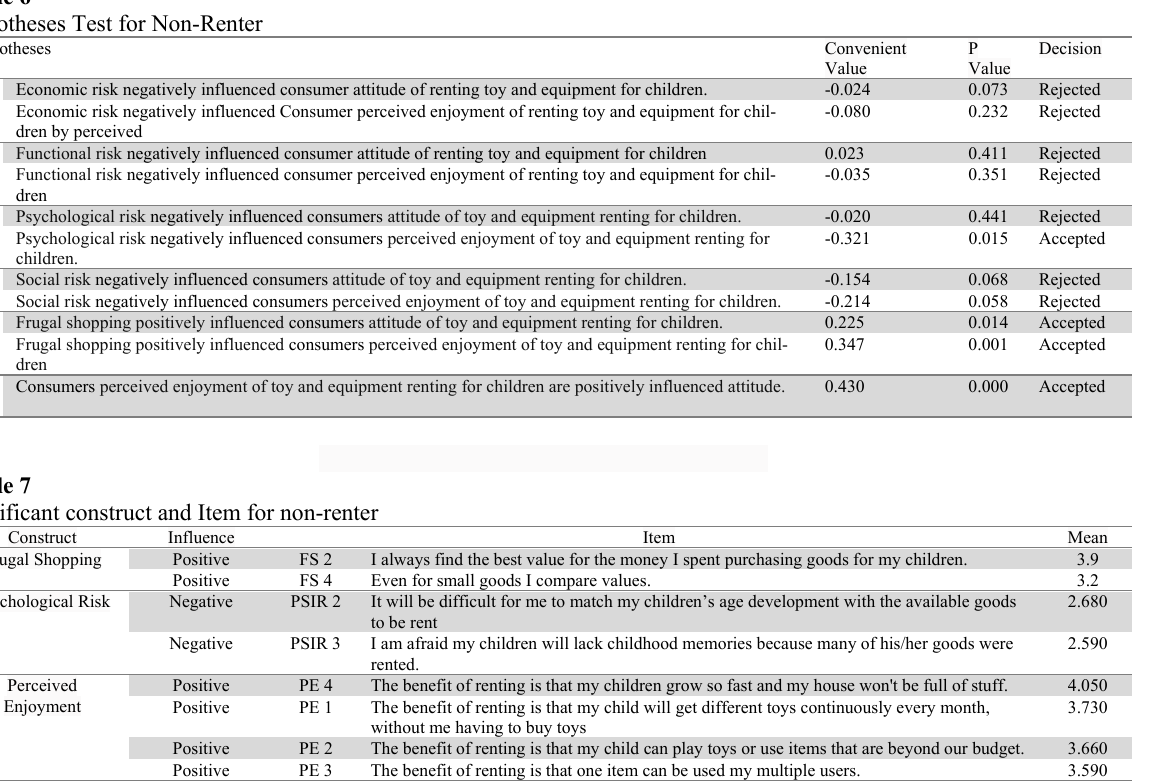
P Decision Value Value